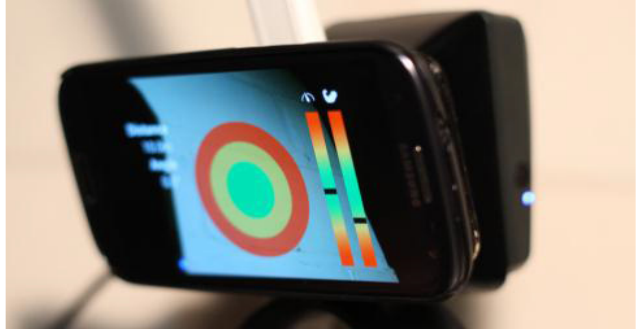
Figure 1. ArcAid App running a on smartphone which is attached to the bow using the specifically designed ArcAid